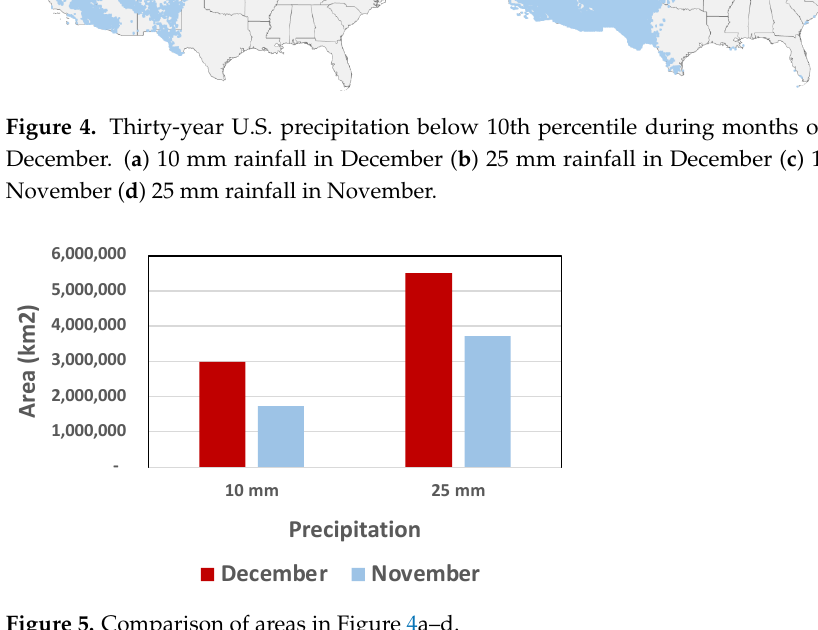
Figure 6. Combination of precipitation (25 mm threshold) and temperature (at 32 °F and 28 °F) for November and December (all 10th percentile) note: 32 °F = 0 °C, 28 °F = −2 .2 °C). ( a ) 25 mm rainfall and 32 °F in December ( b ) 25 mm rainfall 32 °F in November ( c ) 25 mm rainfall and 28 °F in Decem- ber ( d ) 25 mm rainfall and 28 °F in November.